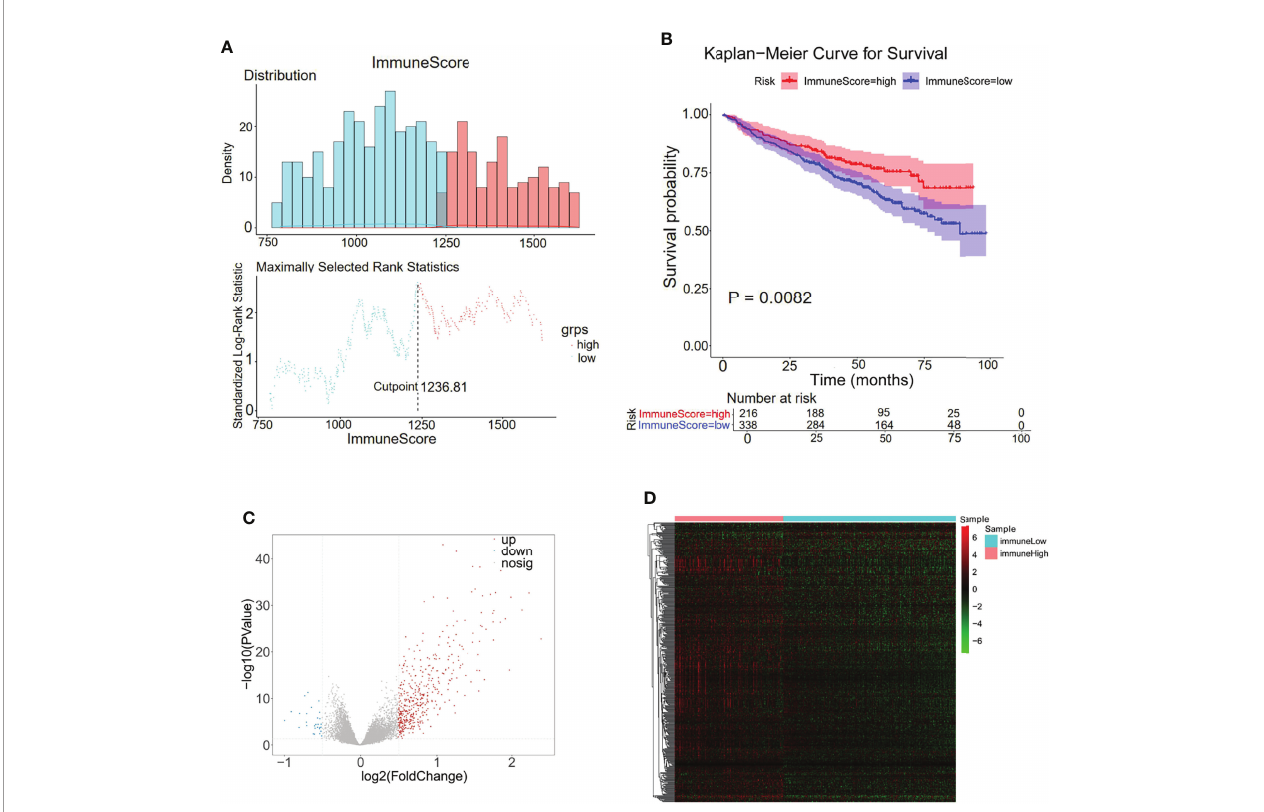
FIGURE 3 | Differentially expressed analysis of immune-related 470 genes for MM. (A) The distributions of immune scores across multiple myeloma samples in the GSE24080 datasets. (B) Kaplan – Meier analysis of the different immune scores to predict patient survival. (C , D) In total, 470 immune-related differentially expressed genes were identi fi ed with hierarchical cluster analysis for